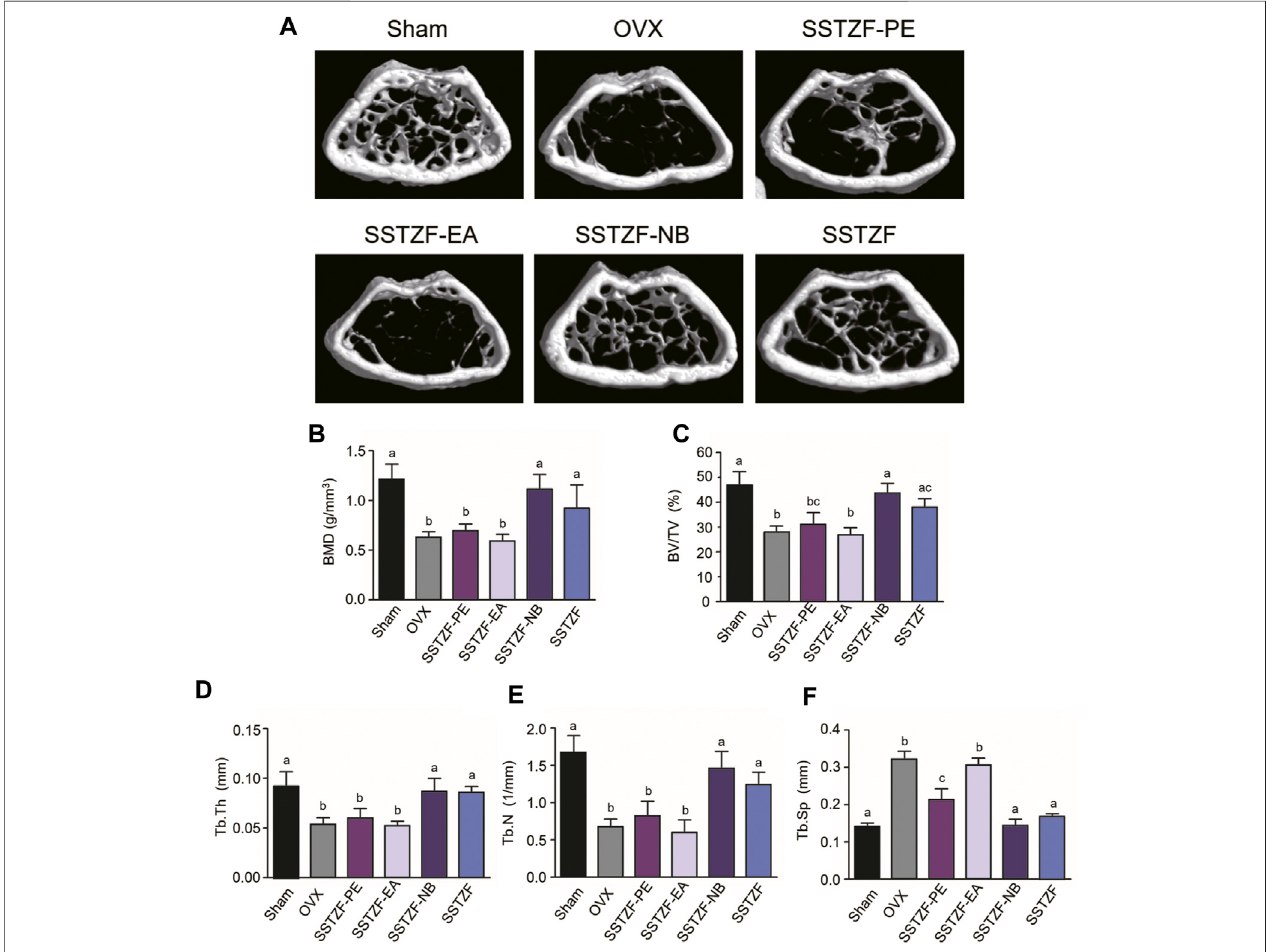
FIGURE 1 | SSTZF-NB prevents bone loss in OVX mice. (A) Representative μ CT images of each group. Quanti fi cation of microstructural data including BMD (B) , BV/TV (C) , Tb.Th (D) , Tb.N (E) ,and Tb.Sp (F) .a – d:Themeans not sharing acommon letter aresigni fi cantly differentamongthe groups at p < 0.05 byone-wayANOVA with Duncan ’ s multiple-range